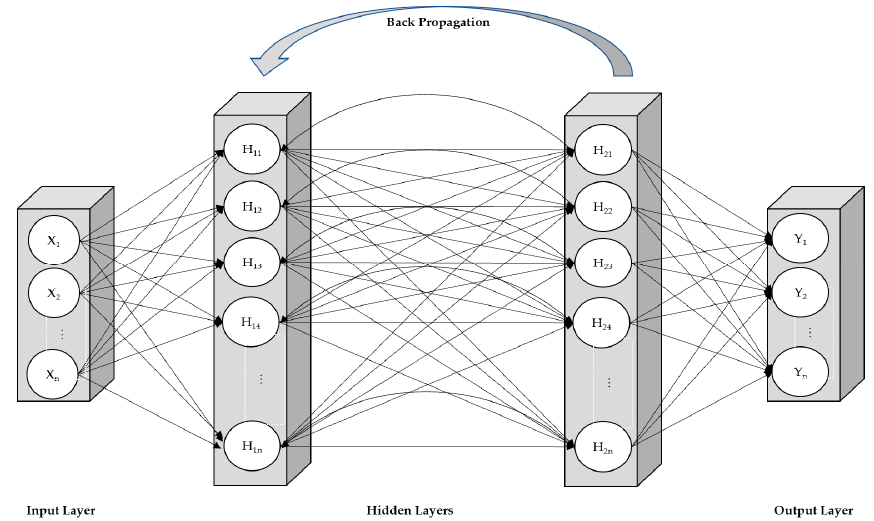
Figure 1. A simple RNN.